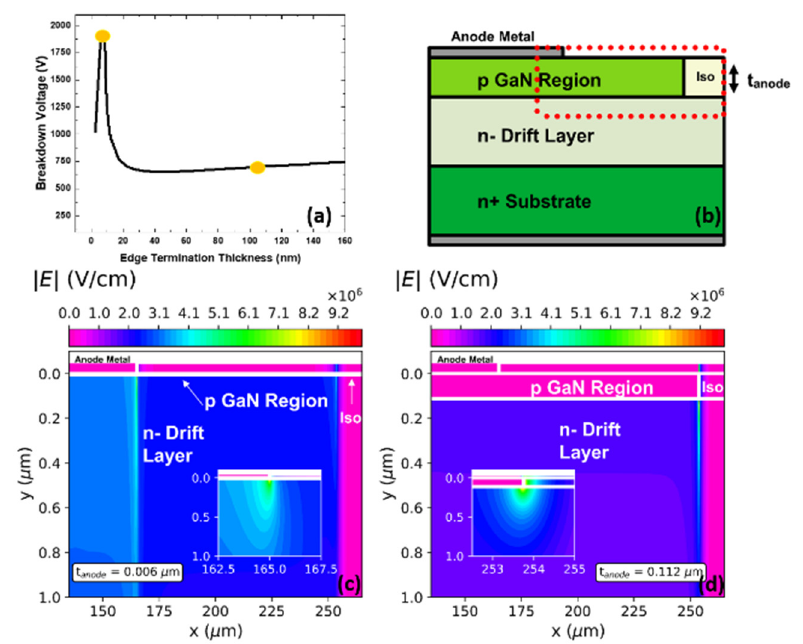
Figure 4. TCAD simulations of avalanche breakdown in devices with varying edge termination region thickness. ( a ) Breakdown voltage vs. edge termination thickness, for anode doping of 2 × 10 19 cm − 3 ; ( b ) the simulated structure schematics; ( c ) 2D electric filed distribution at t ET = 6 nm; ( d ) 2D electric filed distribution at t ET = 112 nm.